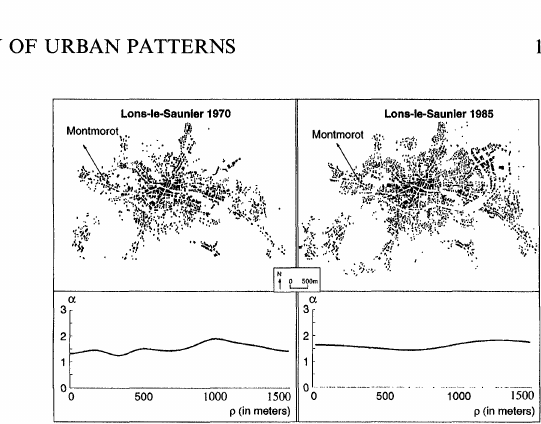
FIGURE 9 The scaling behavior of Montmorot near Lons- le-Saunier at two periods. Due to the urbanisation a